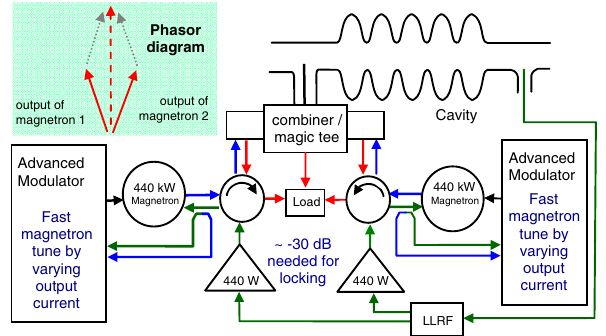
FIG. 1. Amplitude control scenario utilizing two magnetrons operating with a variable phase offset.